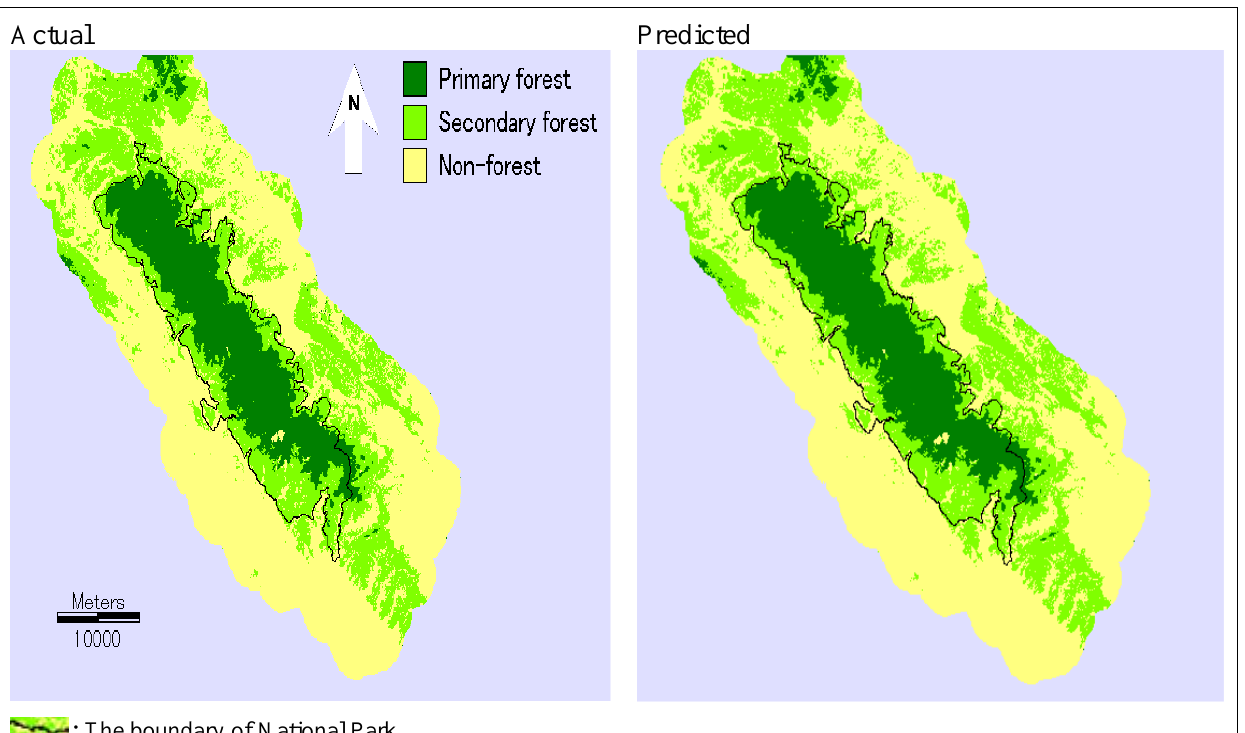
Figure 9. Actual versus predicted forest cover in 2007.